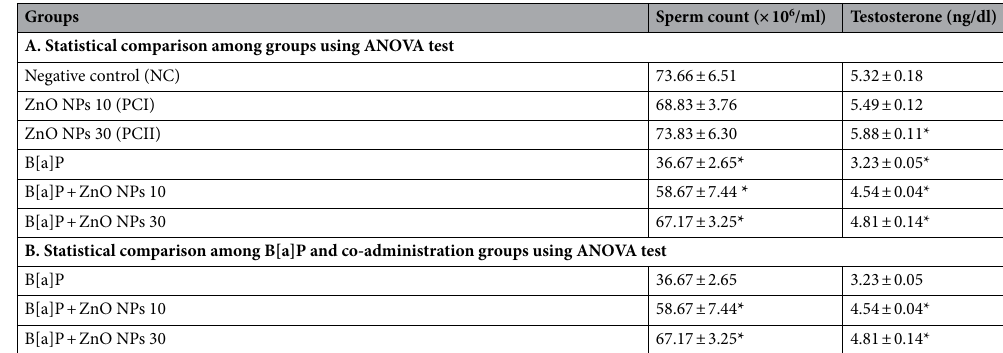
Table 4. Effect of zinc oxide nanoparticles (ZnO NPs) on serum testosterone and sperm counts in benzo[a] pyrene (B[a]P)-challenged male rats. Values are presented as mean ± standard deviation. Values with superscript * within the same column means a significant difference from the NC group in table A and from B[a]P in table B at P <